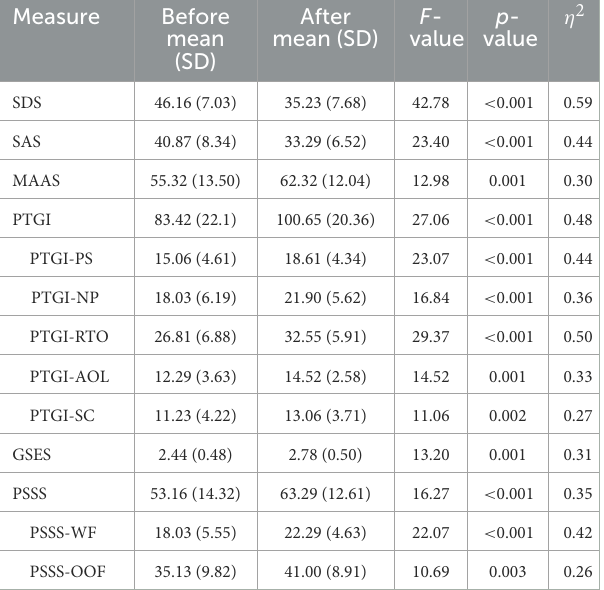
TABLE 3 Scores on outcome measures pre- and post-MLG intervention ( N =